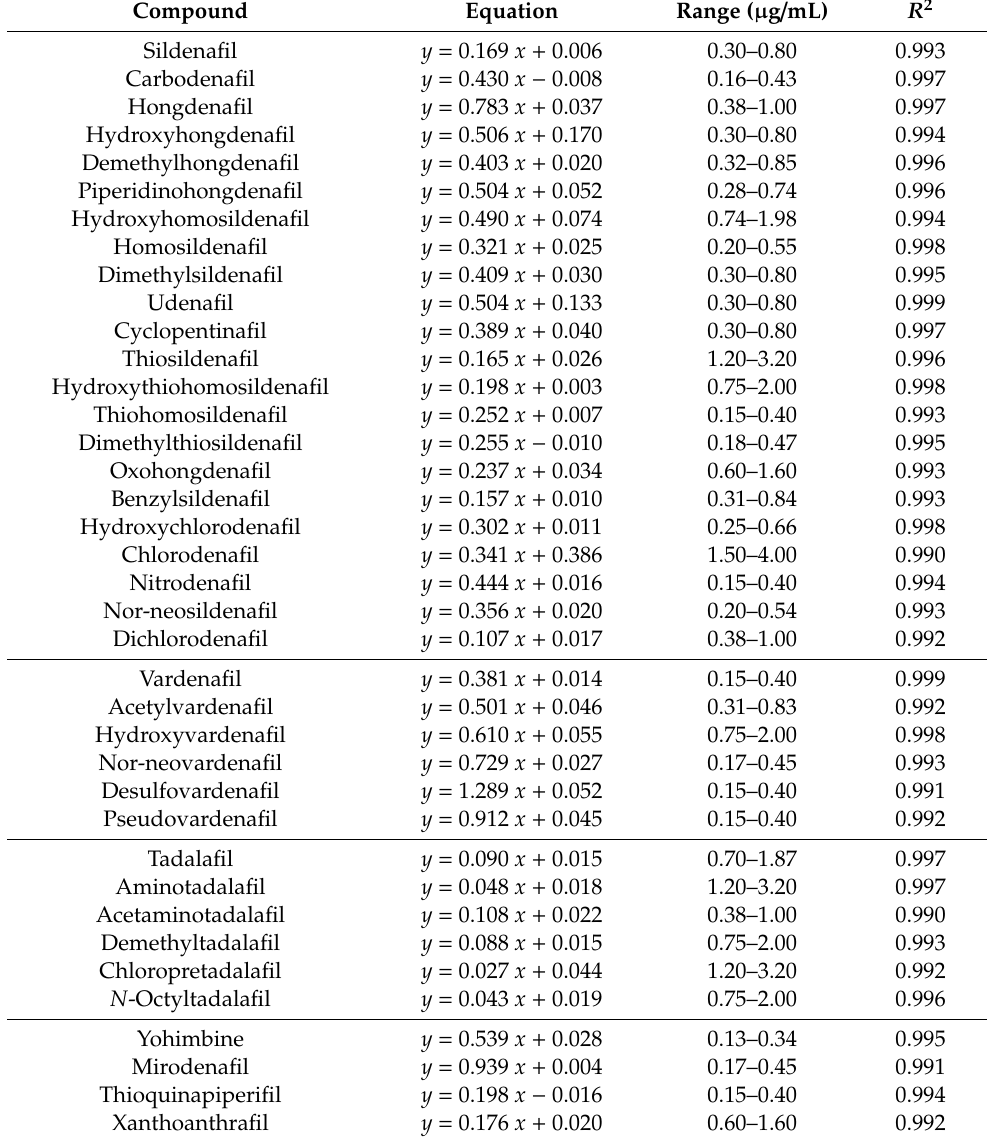
Table 2. Linear regression equations and linear correlation coe ffi cients of PDE-5 inhibitors and their